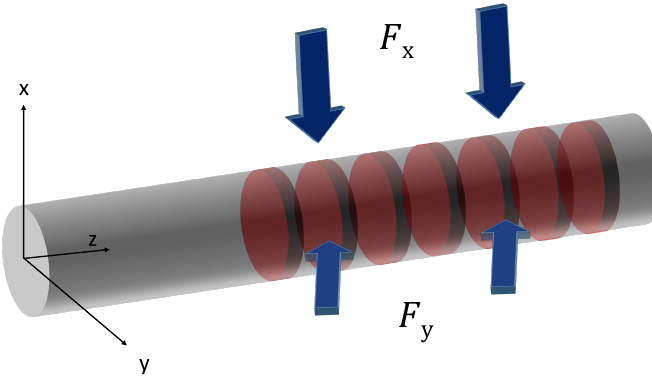
Figure 3. Two different strains on an optical fibre cause birefringence.